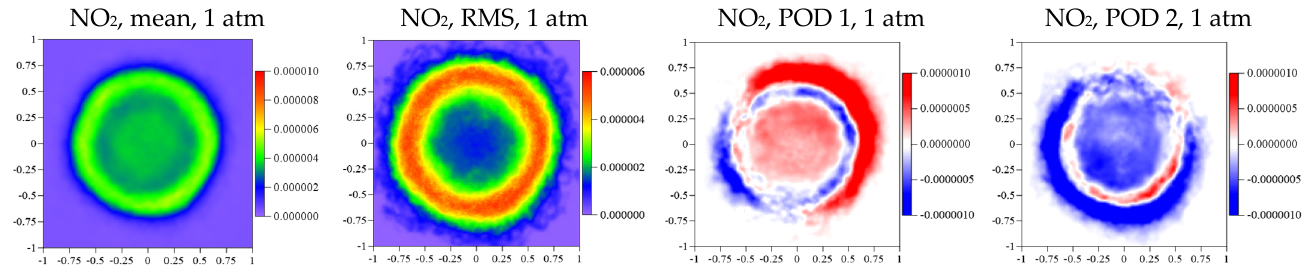
Figure 21. Mean and variation in the NO concentration field and the first and second POD modes.